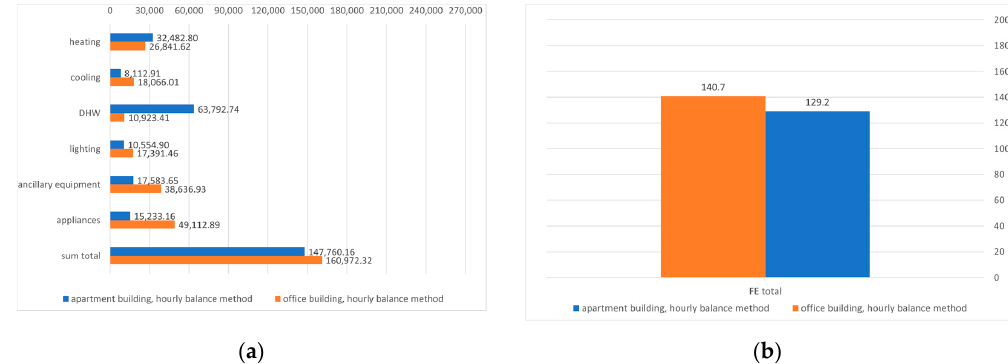
Figure 12. Final energy. ( a ) Final energy for both building uses with cooling, ( b ) Final energy indicators for both building uses with cooling.